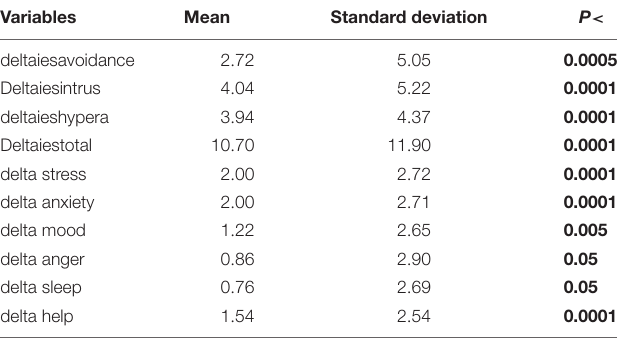
TABLE 3 | Univariate statistics relative to the delta variables.